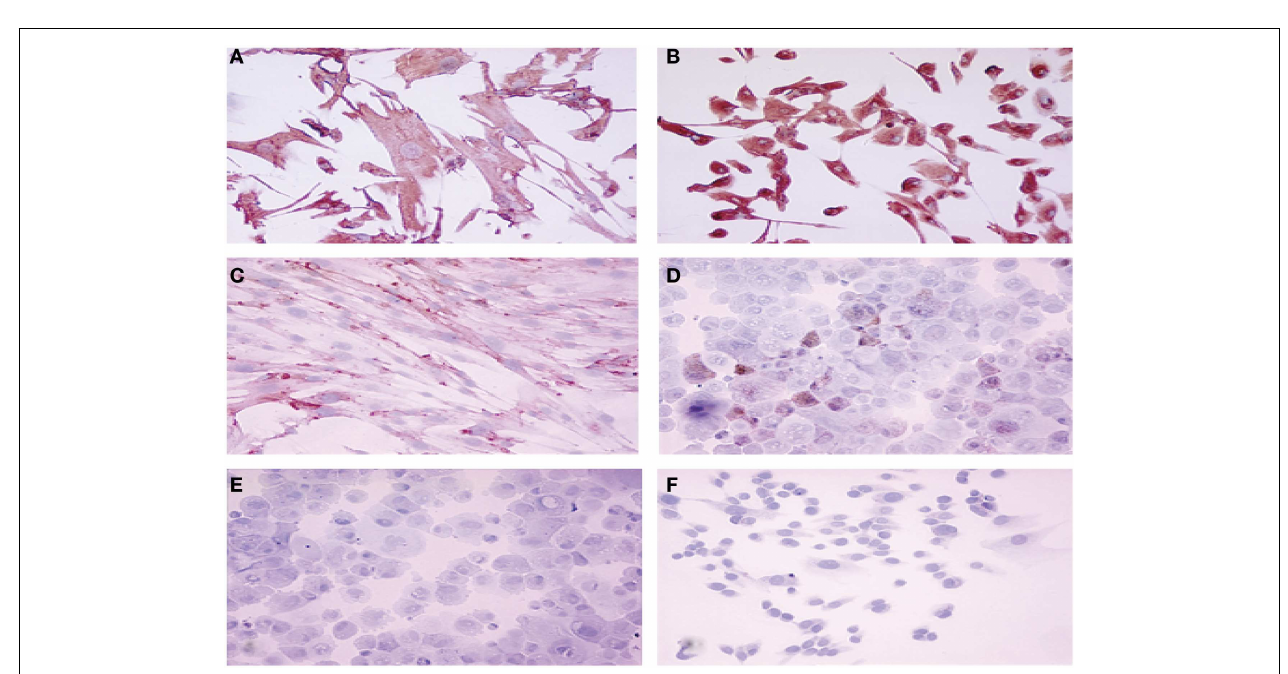
(second passage) .The culture was established from a large peritoneal implant (black lesion). Note presence of large polymorphic adherent cells growing in monolayer. Original magnification × 400; in B,C,D,E,F ( × 280).